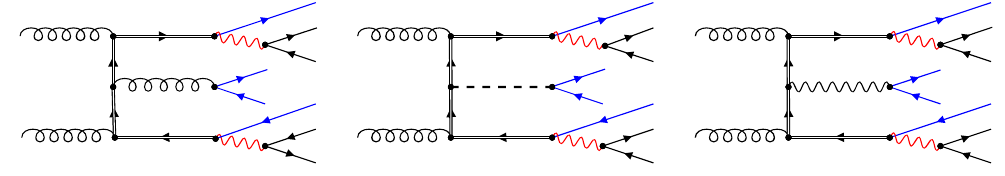
Figure 1 . Representative tree level Feynman diagrams for the QCD pp → t ¯ tb ¯ b production process as well as for pp → t ¯ tH ( H → b ¯ b ) and pp → t ¯ tZ ( Z → b ¯ b ) that lead to the same e + ν e µ − ¯ ν µ b ¯ b b ¯ b final state respectively at O ( α 4 α 4 ) and O ( α 2 α 6 ) . The double line indicates the top (anti-top) quark, the s s blue line corresponds to bottom (anti-bottom) quarks, whereas the W gauge boson is depicted in red. Furthermore, the dashed line represents the SM Higgs